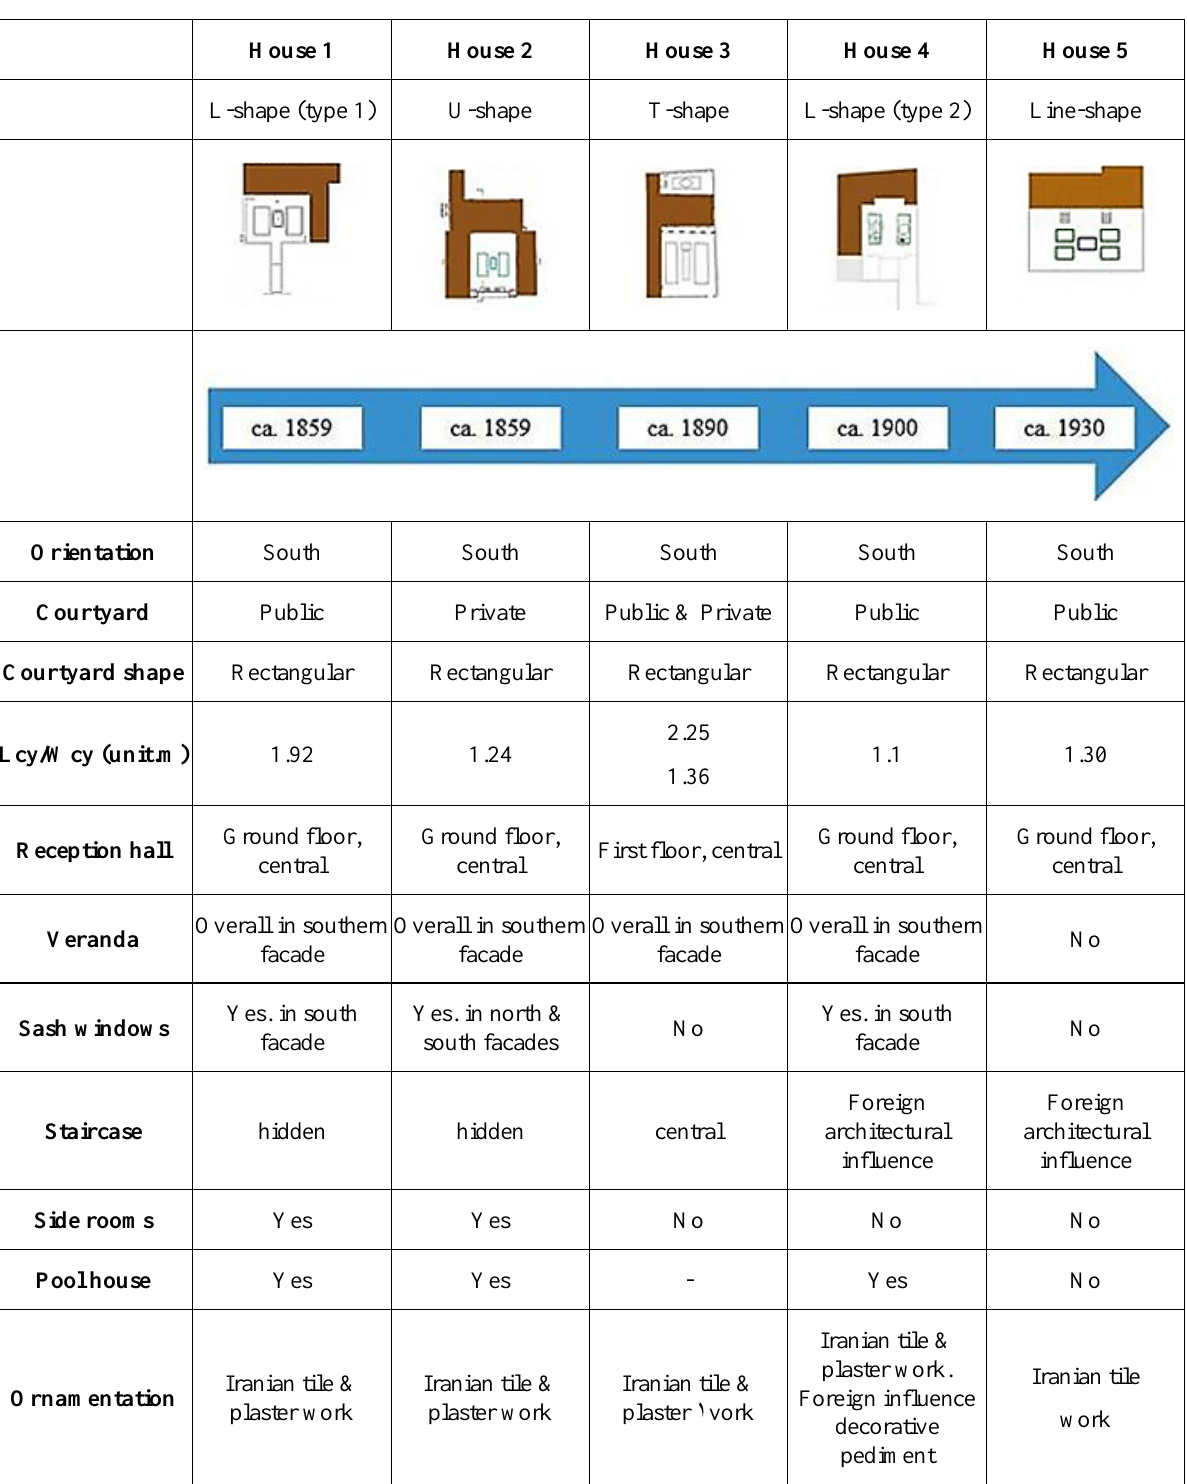
Table 2. Comparison between 5 traditional courtyard houses of the city of Tabriz and their typology transformation over